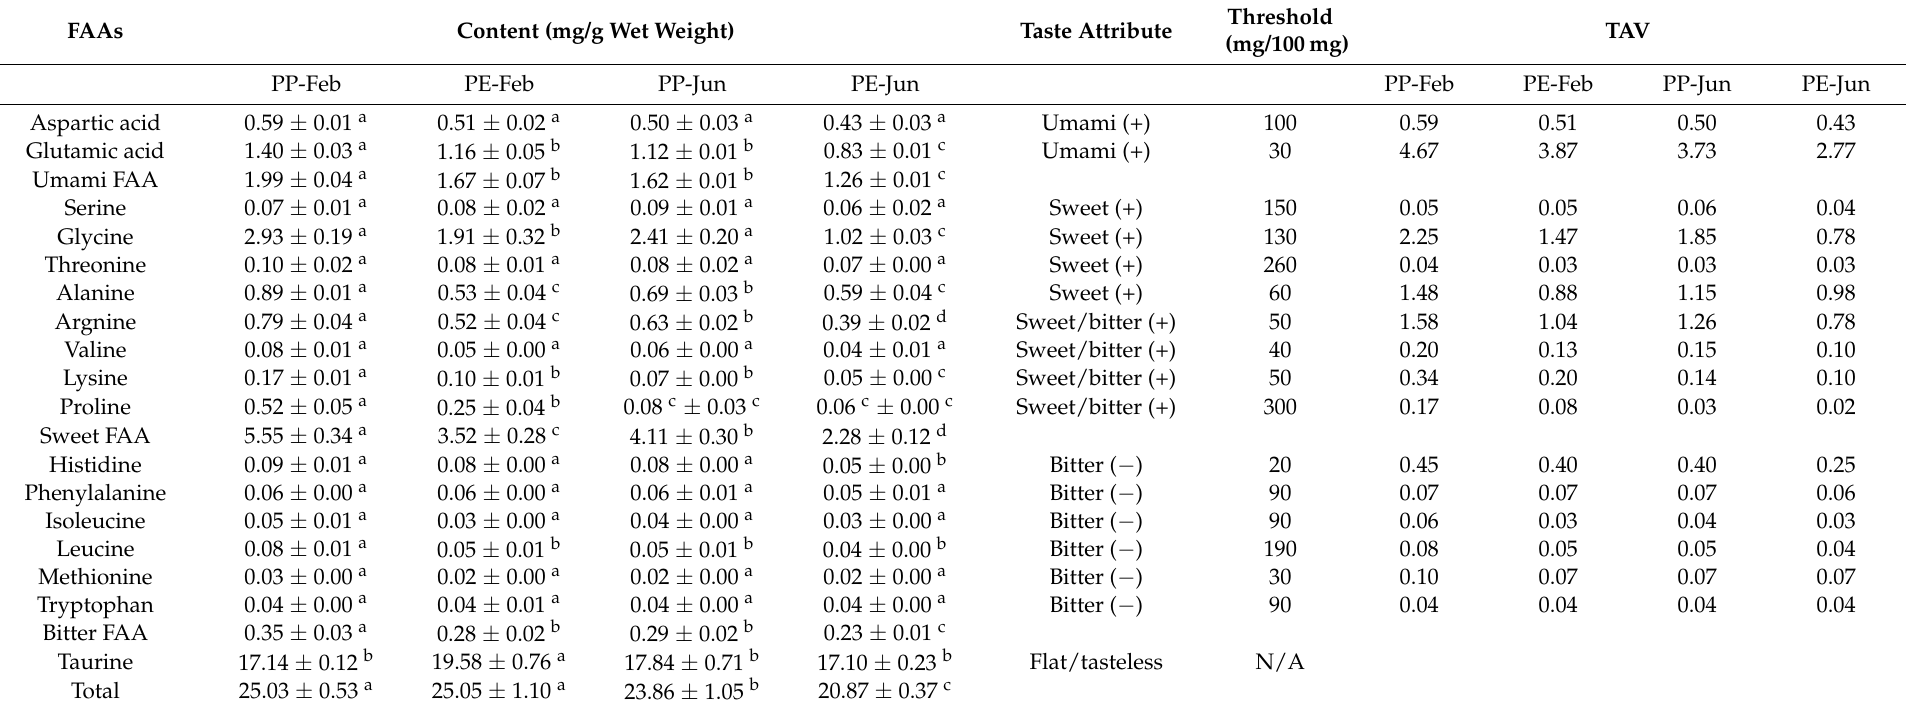
Table 6. The contents, taste attributes (+ pleasant, − unpleasant), taste thresholds, and TAVs of free amino acids (FAA) of two P. f. martensii selective strains in different